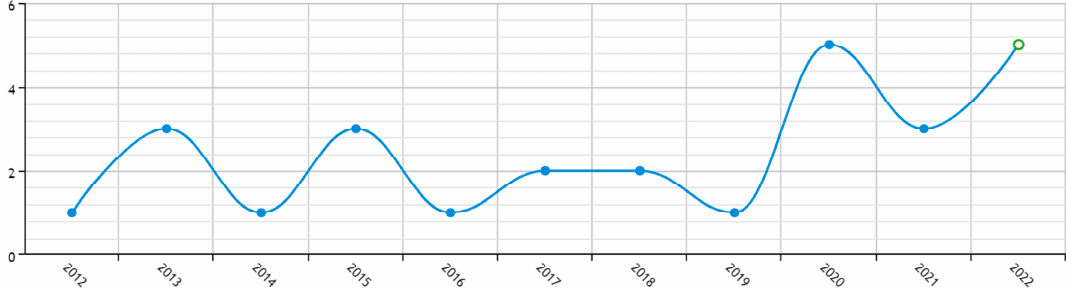
Figure 2. Number of articles published in 2012–2022 (high level papers).